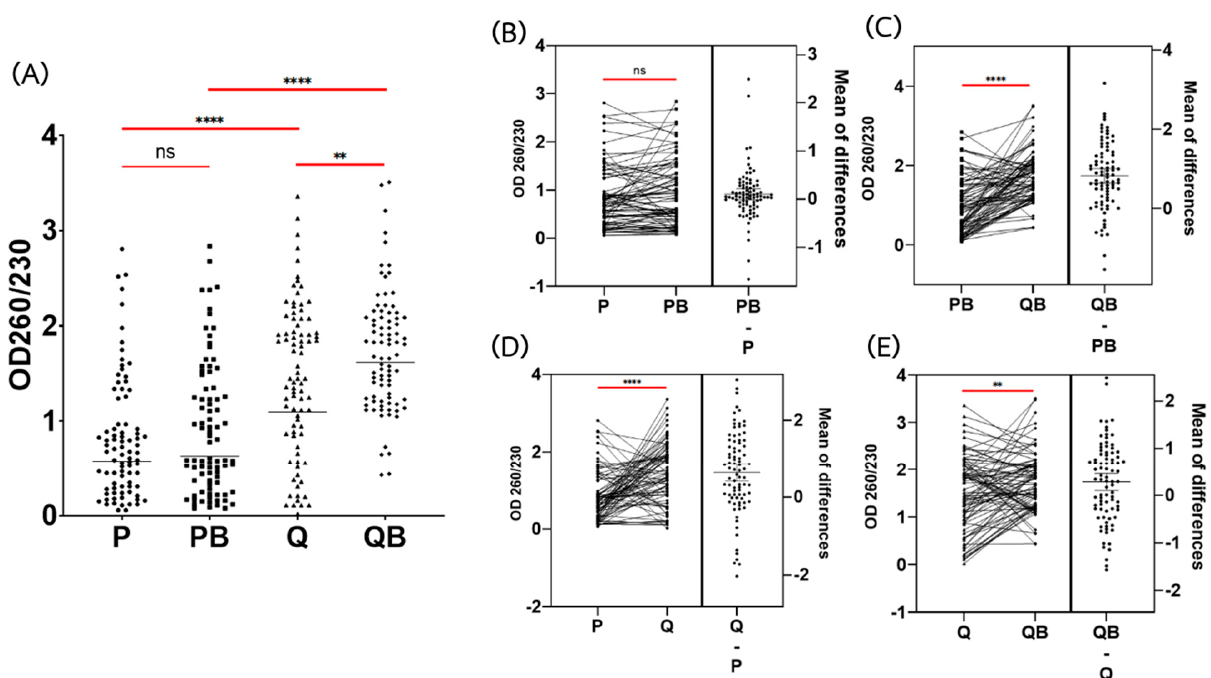
Figure 3. Comparison of the OD260/230 absorbance ratios of genomic DNA extracted by the phenol- chloroform extraction method (P), the phenol-chloroform extraction method with glass beads (PB), the QIAamp Fast DNA Stool Mini Kit (Q), and the QIAamp Power Fecal Pro DNA Kit (QB). ( A ) Dot plot of DNA concentrations using the extraction methods. Each dot indicates the DNA concentration of each sample. ( B – E ) Estimation plot of DNA concentration among the extraction methods. Each line in the left panel indicates the comparison of DNA concentration of each sample extracted by each method. Each dot in the right panel indicates the differences among the DNA concentrations in each sample. The bar indicates the mean of the differences between concentrations. **** Statistical differences using a paired t -test ( p < 0.0001), ** Statistical differences using a paired t -test ( p < 0.01), ns: non-significant differences ( p > 0.05).